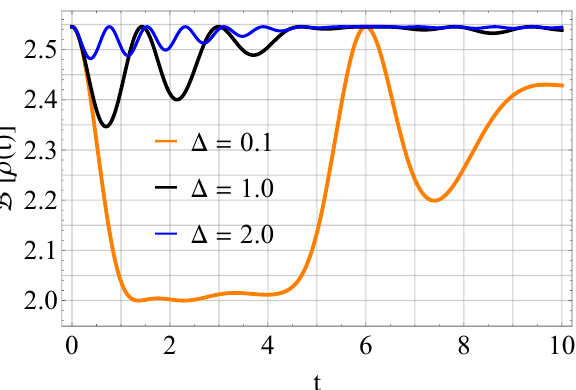
Figure 7. B [ ρ ( t )] for three values of ∆ . The other parameters are r = 0.9, ω = π /6, and b = 0.5.